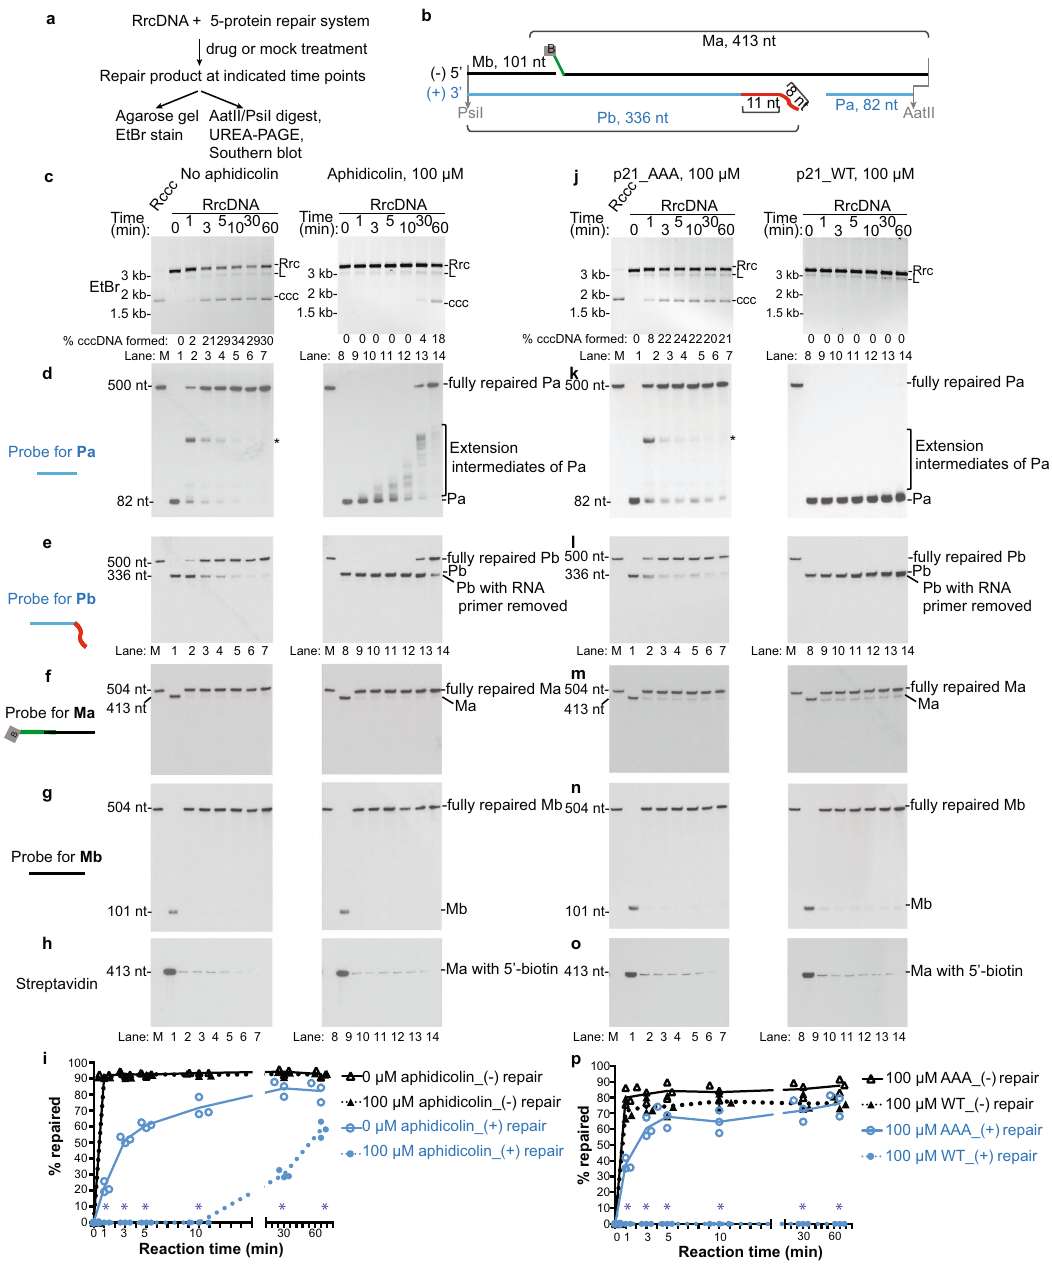
Fig. 6 Aphidicolin and cyclin-dependent kinase inhibitor p21 peptide speci fi cally inhibit the repair of the rcDNA plus-strand. a Schematic of time course experiments to test the effects of aphidicolin and p21 peptides on repair of HBV RrcDNA plus- and minus-strand repair. b A simpli fi ed schematic depicting the four fragments in unrepaired RrcDNA digested by AatII/PsiI. c cccDNA formation of the RrcDNA substrate under treatments of mock (1% DMSO, lanes 1 – 7) or aphidicolin (100 μ M in 1% DMSO, lanes 8 – 14) was detected by EtBr-containing agarose gel. d – h Repair of plus-strand fragments Pa, Pb, and minus-strand fragments Ma, Mb was monitored by Southern blot d – g or streptavidin blot h . i Repair ef fi ciency of plus-strand e and minus-strand f was calculated and plotted as in Fig. 2i. ( − ) and ( + ) repair denote repair of minus and plus-strands, respectively. M, marker. j – p , same as c – i , except that AAA mutant p21 peptide was used as mock treatment, and WT p21 peptide was used as inhibitor to inhibit plus-strand synthesis. All experiments were repeated thrice, and each individual measurement is plotted. The lines connect the average values of three measurements at each time point. Statistical analyses between the repair ef fi ciencies of the minus strand at each time point are performed by two-stage step-up t test method of Benjamini, Krieger, and Yekutieli from Graphpad Prism. P values are 0.0004, 0.000001, 0.0000004, 0.00003, 0.00006, and 0.007 for indicated time points in i . P values are 0.00007, 0.00007, 0.00007, 0.0001, 0.00005, and 0.00005 for indicated time points in p , and statistically signi fi cant p values are indicated by “ * ” . Rrc, RrcDNA; rL, recombinant linear RrcDNA, ccc, cccDNA. Source data are provided as a Source Data fi le.